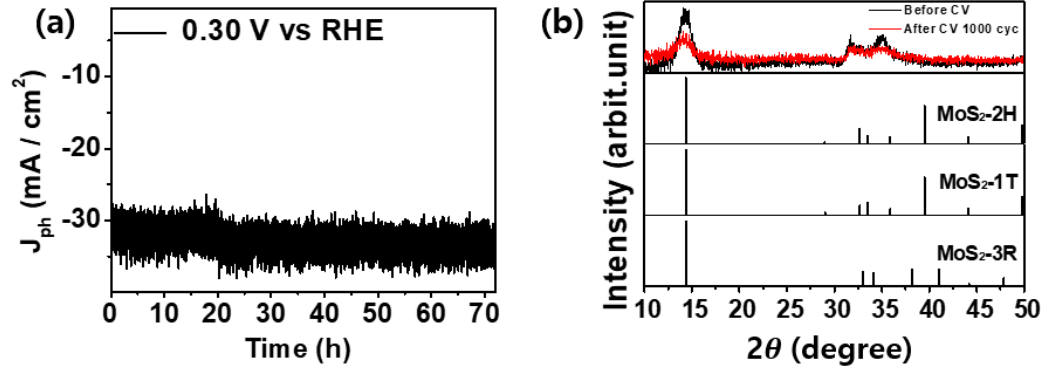
Figure 4. ( a ) Chronogalvanometry of our p -Si/SiO x /MoS 2 photocathode under illumination with an applied bias of − 0.3 V vs. RHE and ( b ) XRD patterns of the photocathode before and after